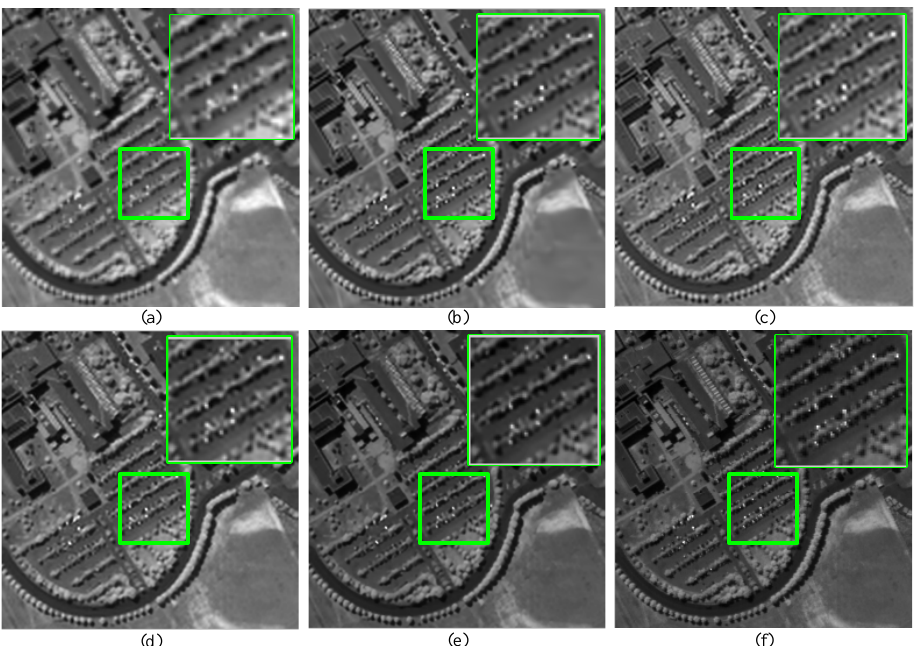
Figure 6. The SR results (band 85) of different methods by an upscaling factor of two, the testing data is cropped from Pavia University with size 256 × 256. ( a ) Result of Bicubic, ( b ) result of spectral-spatial group sparse representation HSI SR method (SSG) [27], ( c ) result of super resolution CNN (SRCNN) [40], ( d ) result of 3D-CNN [32], ( e ) result of the proposed MW-3D-CNN, and ( f ) original HR image.